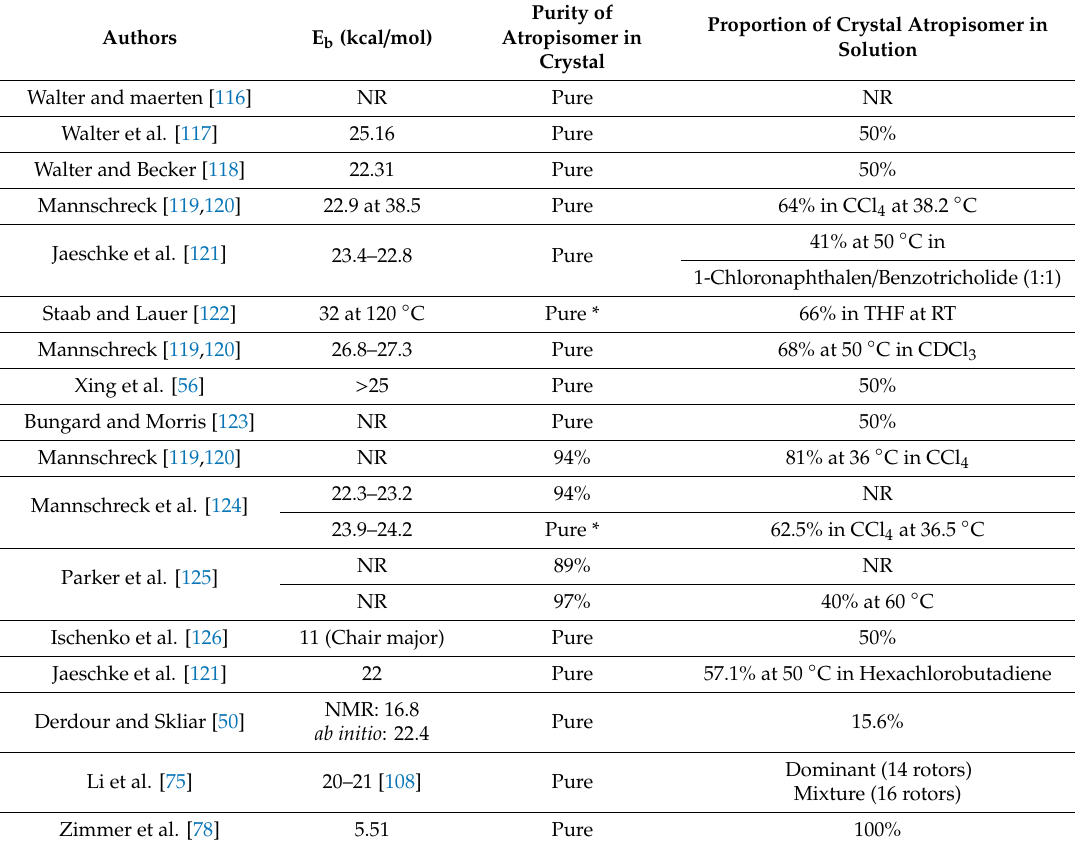
Table 1. Literature accounts of crystallization of